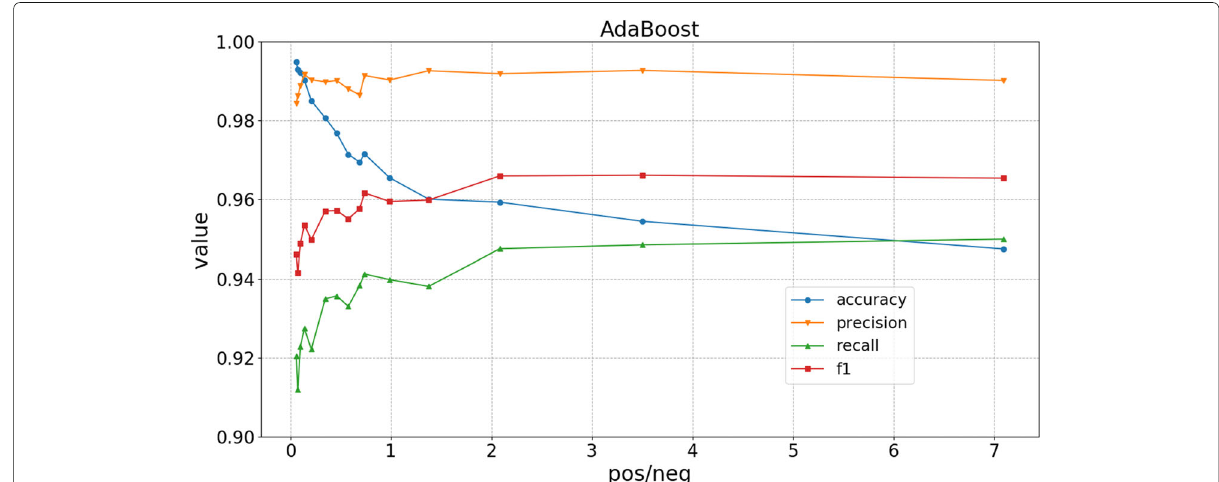
Fig. 9 Result of AB with different ratios of positive/negative samples. We tested the AdaBoost classifiers using the following positive/negative ratios: 7.089, 3.499, 2.081, 1.375, 0.988, 0.727, 0.462, 0.346, 0.278, 0.139, 0.099, 0.075, and 0.058